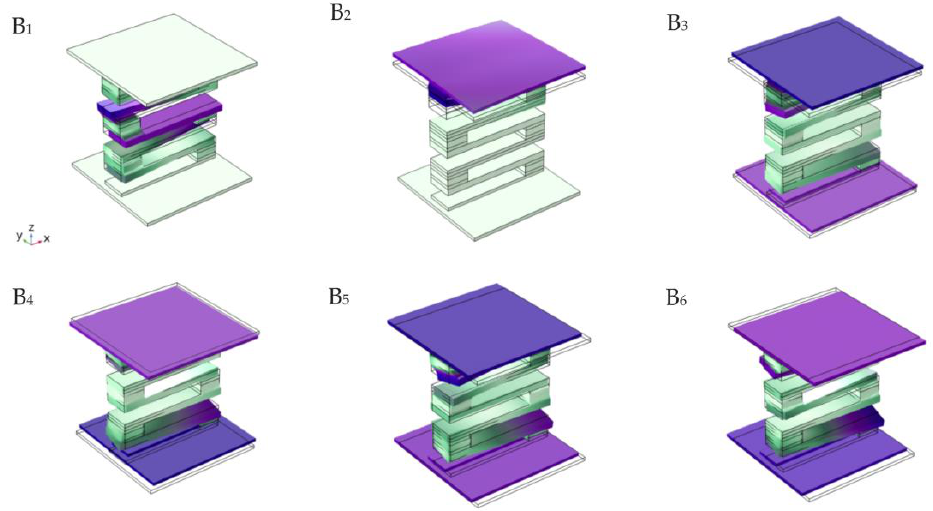
Figure 7. The displacement fields of eigenmodes labeled within the first band gap in Figure 5a.